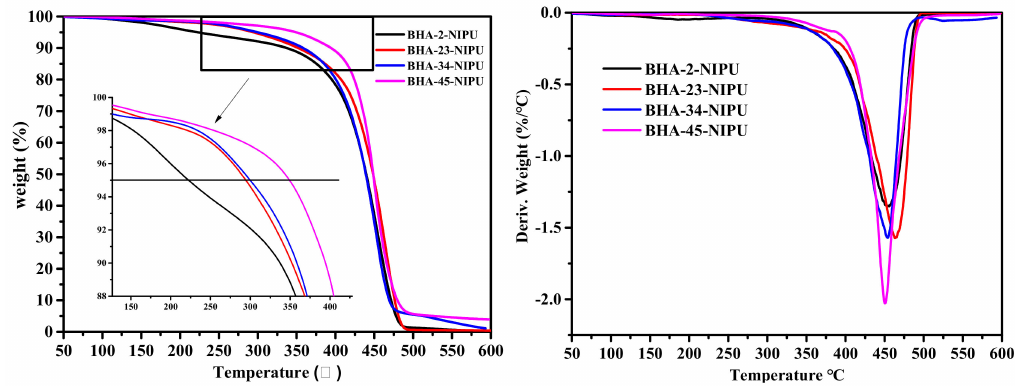
Figure 5. TGA ( left ) and di ff erential thermal gravity (DTG) ( right ) curves of four NIPU-prepolymers.